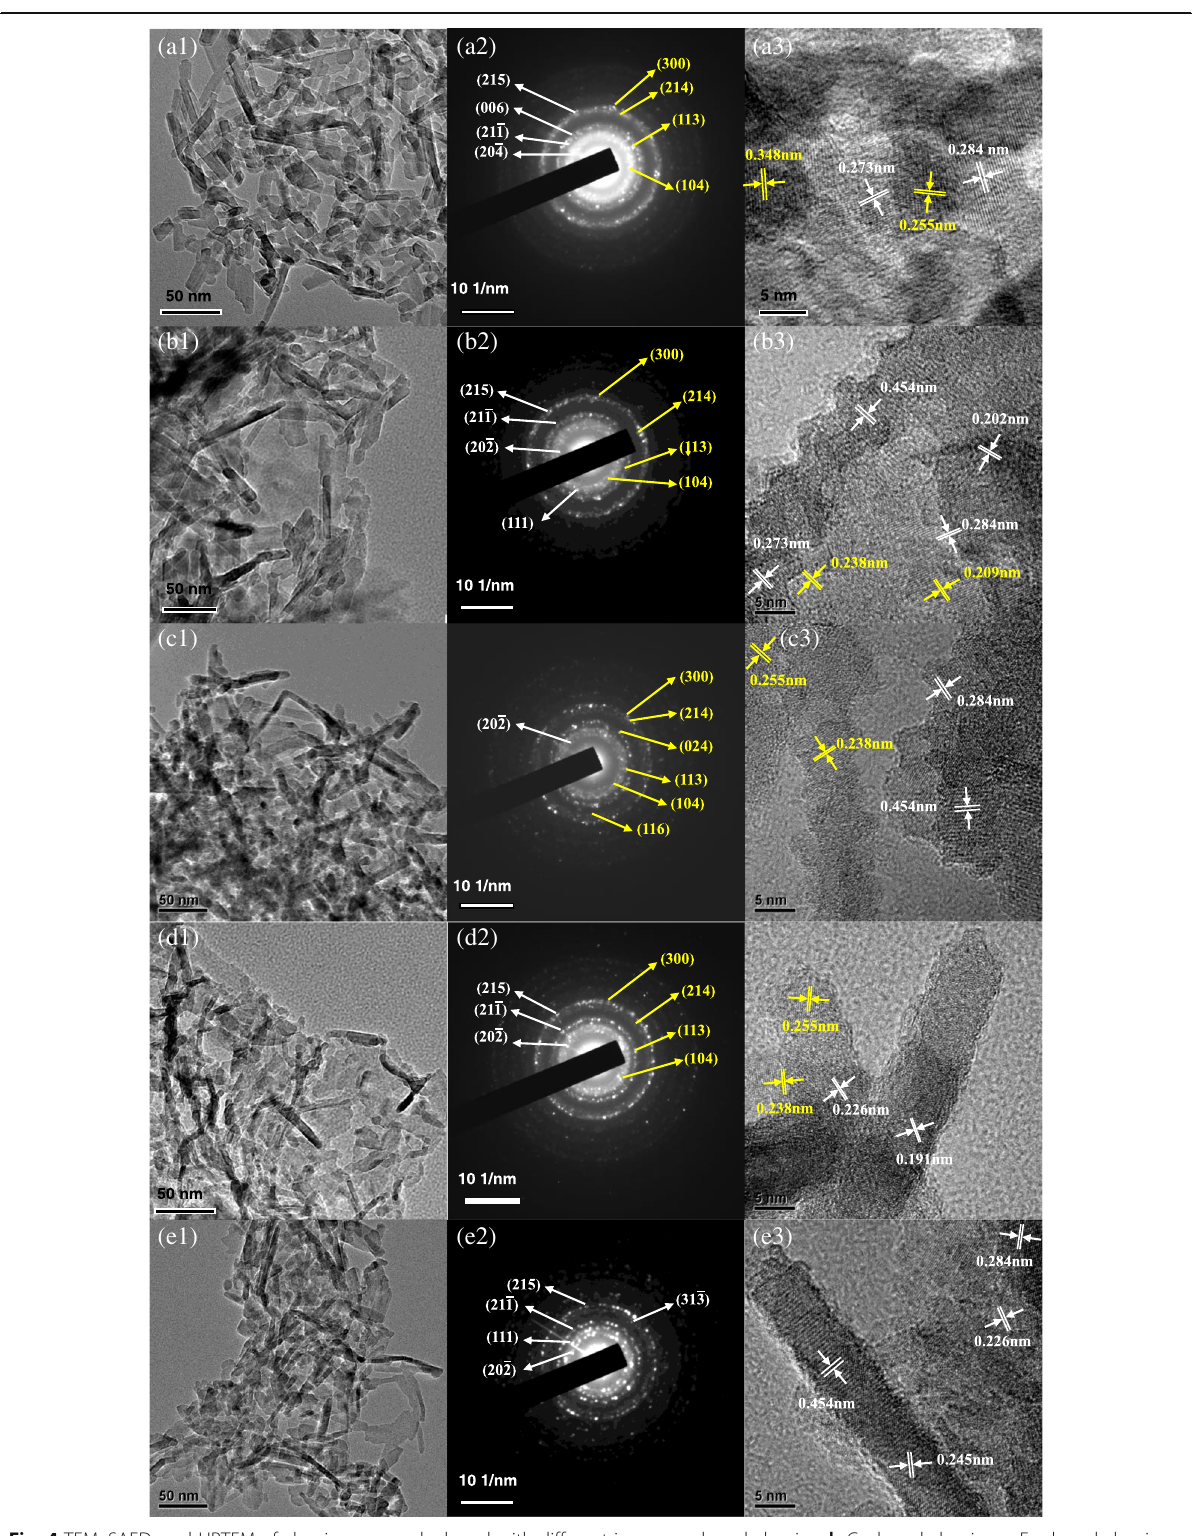
Fig. 4 TEM, SAED, and HRTEM of alumina nanorods doped with different ions: a undoped alumina, b Cr-doped alumina, c Fe-doped alumina, d Mg-doped alumina, and e the alumina prepared from the chromium-containing alumina sludge. (1) TEM; (2) SAED; (3)